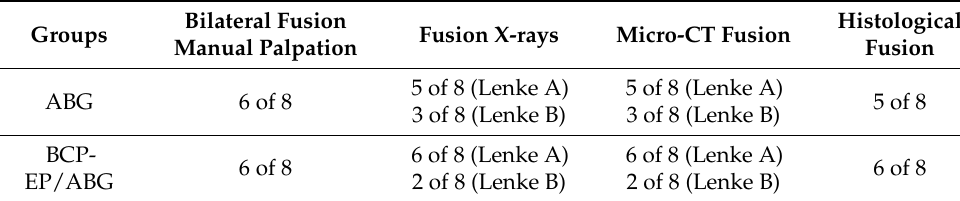
Table 2. Summary of fusion rates in rabbit PLF at 12 weeks post operation for BCP-EP/ABG and ABG.